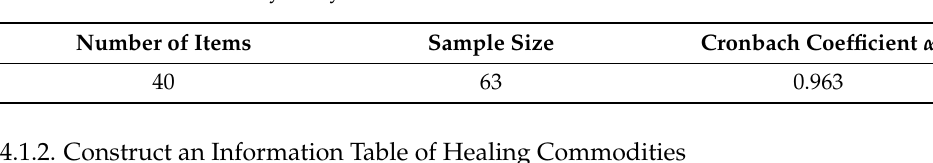
Table 3. Cronbach reliability